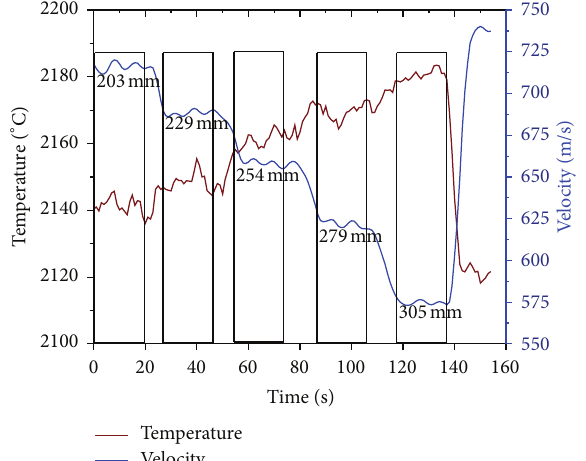
Figure 6: Results of speed and temperature of the particles with the Tecnar Accura Spray equipment.